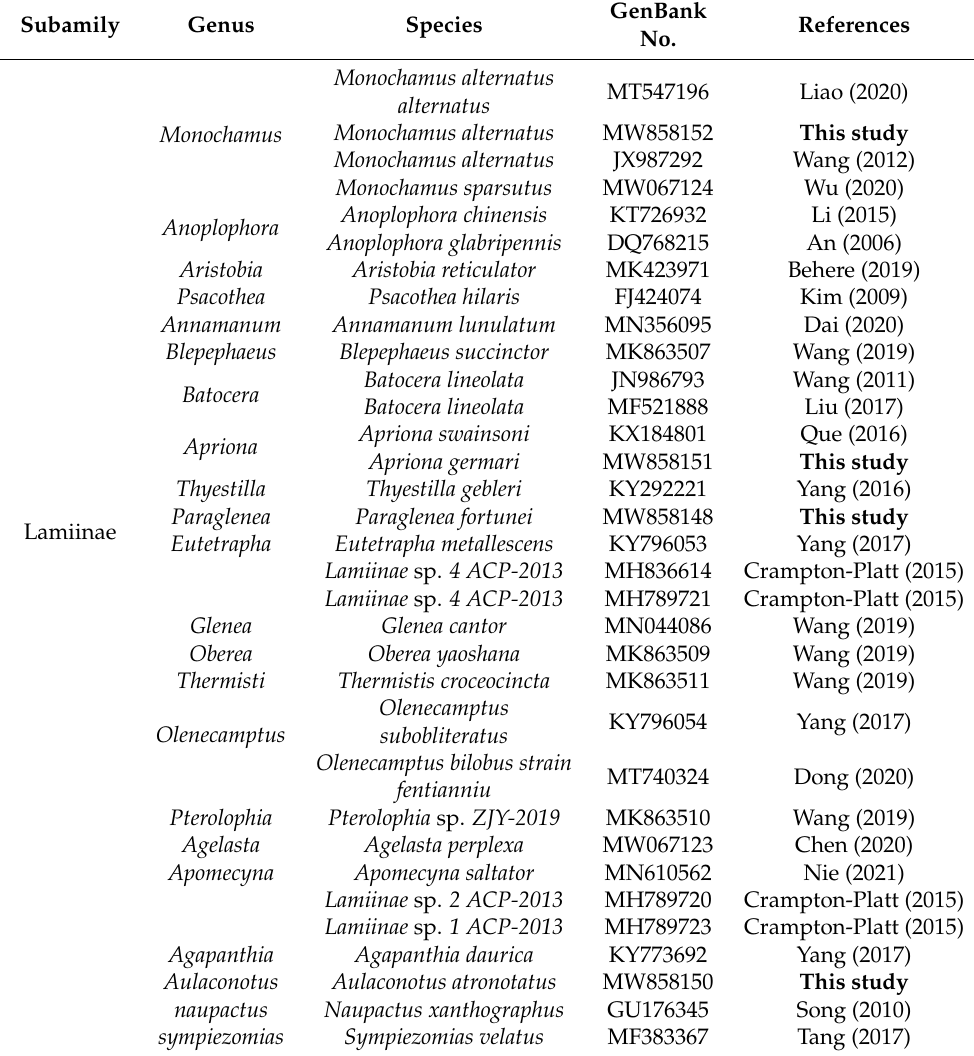
Table 1. Species sample information used in the phylogenetic tree construction in this study.